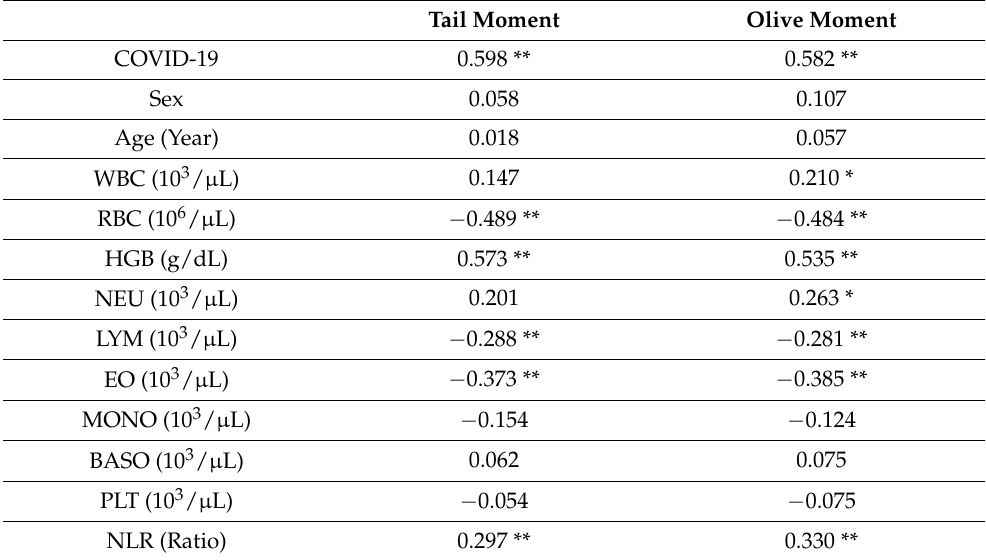
Table 4. Correlation between baseline characteristics, tail moment, and olive moment of COVID-19 patients. Tail Moment Olive Moment COVID-19 0.598 ** 0.582 ** Sex 0.058 0.107 Age (Year) 0.018 0.057 WBC (10 3 / µ L)